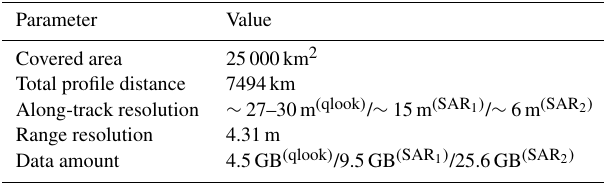
Table 2. Data record